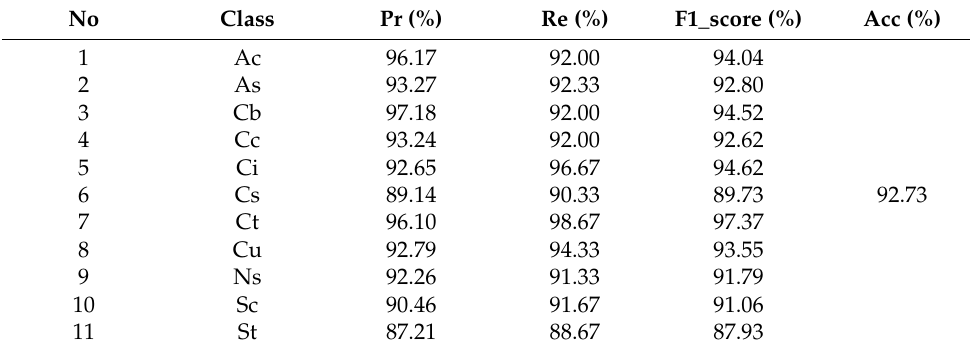
Table 6. The classification results for the CCSN dataset.